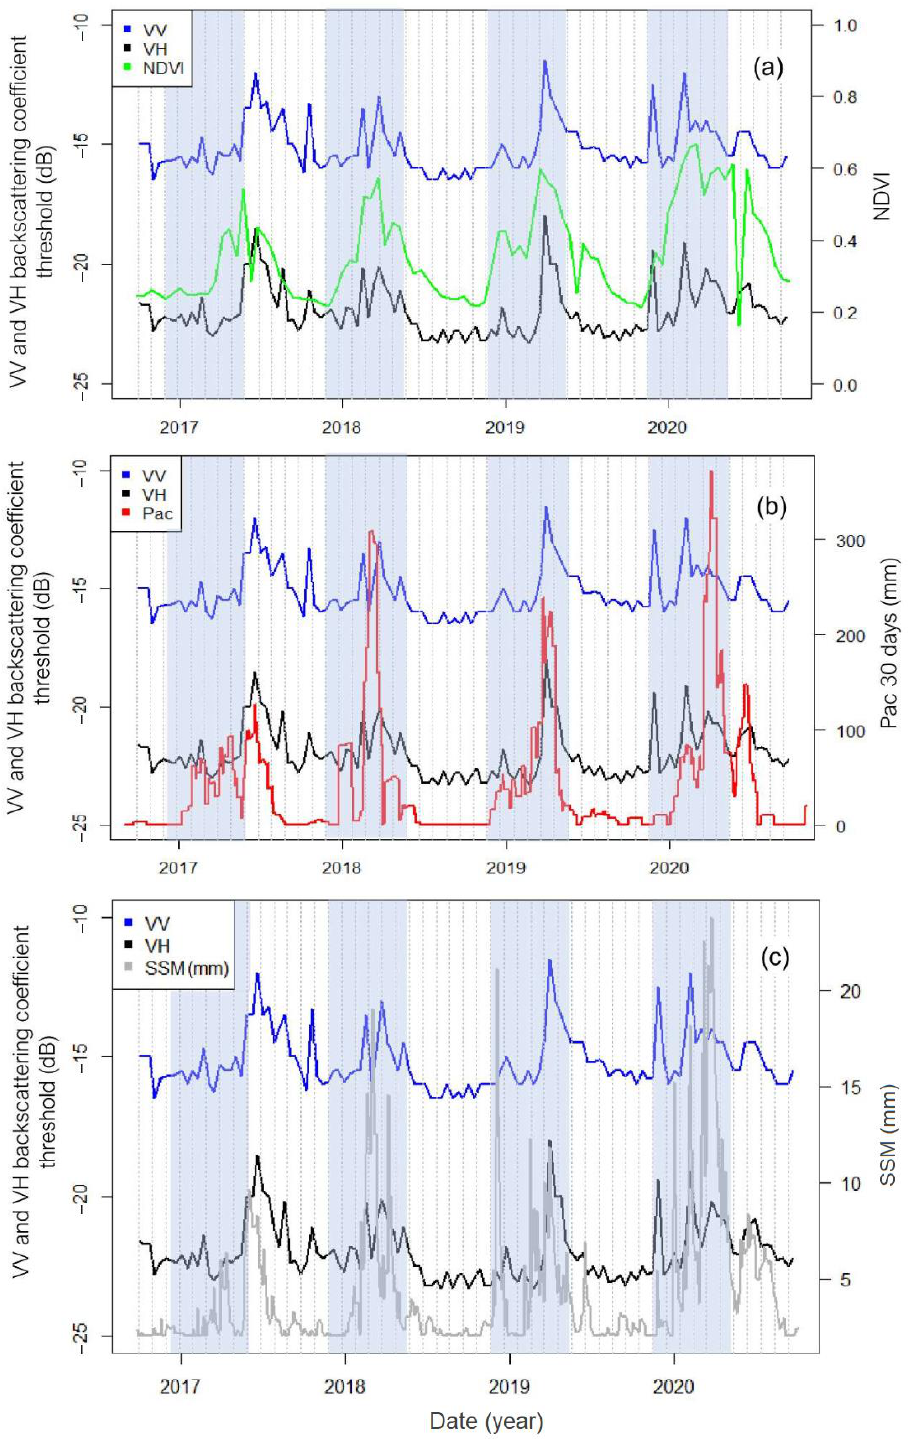
Figure 11. Comparison between VV and VH backscattering coefficient thresholds, NDVI signal ( a ), 30 day accumulated precipitation (Pac30) ( b ), and surface soil moisture (SSM) ( c ). Shaded areas indicate the months corresponding to the wet season.